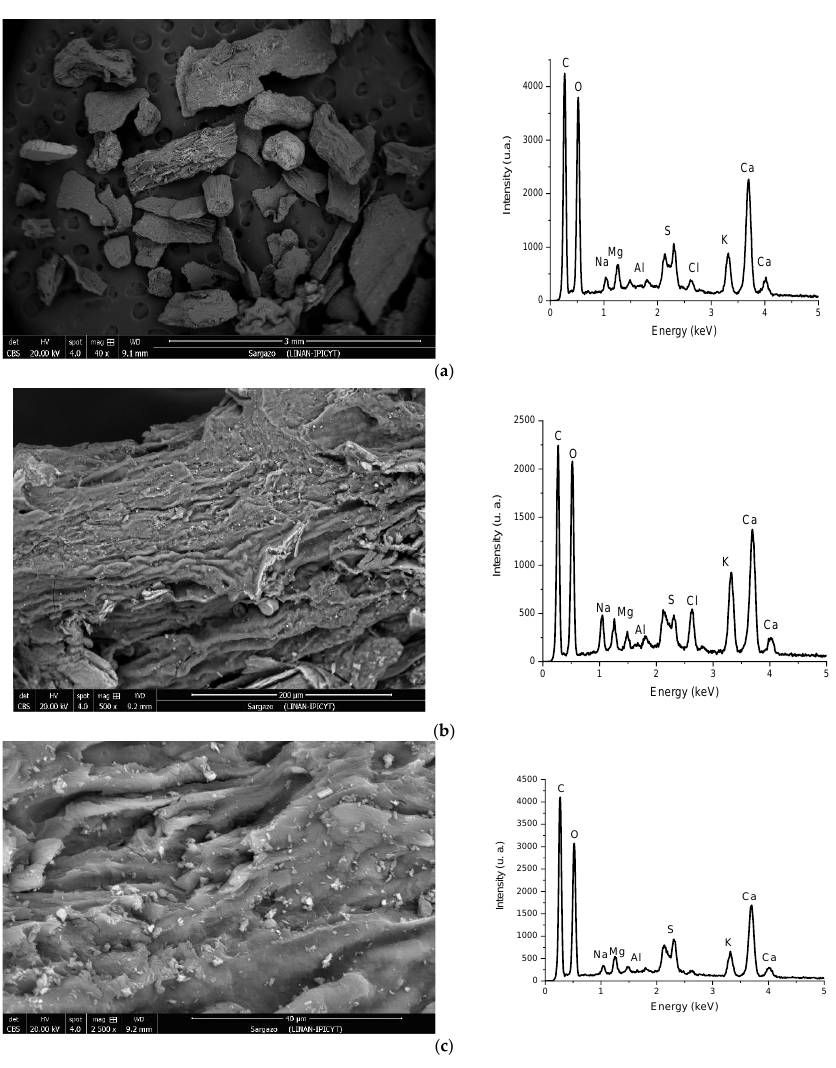
Figure 6. SEM images and EDS spectra of Sargassum at: ( a ) 40×, ( b ) 500×, and ( c ) 2500×.